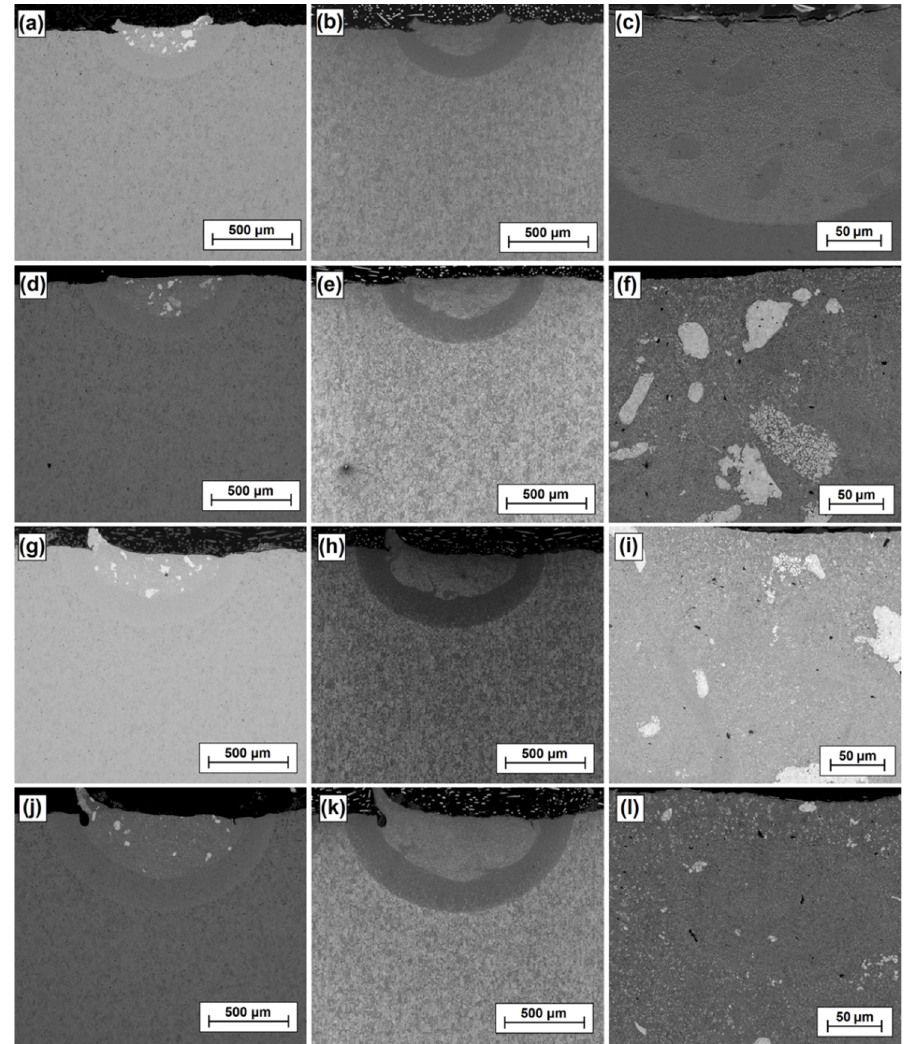
Figure 5. Morphology of Fe/ZrC coatings produced using laser beam powers of 500 W—BSE image ( a ); 500 W—SE image ( b ); 500 W—magnification of melted zone ( c ); 700 W—BSE image ( d ); 700 W—SE image ( e ); 700 W—magnification of melted zone ( f ); 900 W—BSE image ( g ); 900 W—SE image ( h ); 900 W—magnification of melted zone ( i ); 1100 W—BSE image ( j ); 1100 W—SE image ( k ); 1100 W—magnification of melted zone ( l ) .